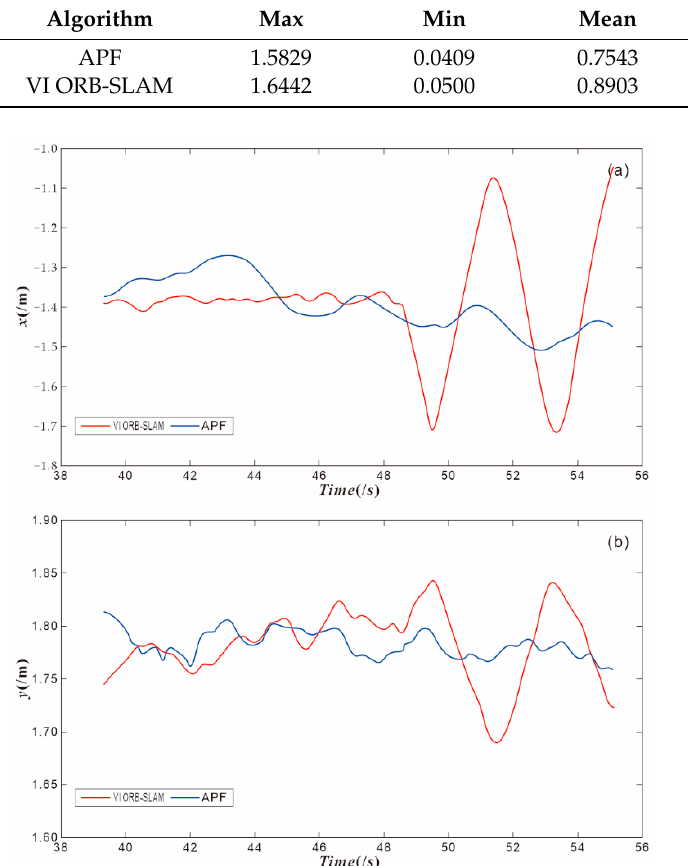
Figure 10. Displacement deviation along the x -axis ( a ) and y -axis ( b ) direction. Table 5. Error analysis of the proposed algorithm and VI ORB-SLAM